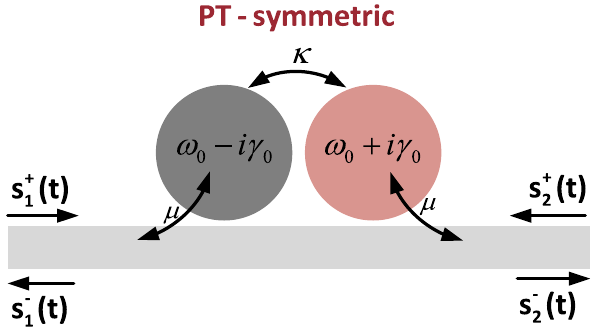
Figure 6: PT-symmetric system side-coupled to